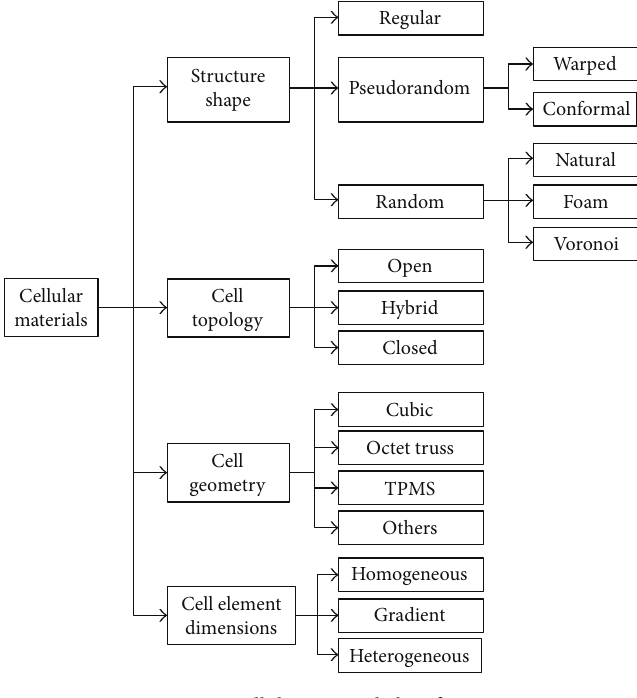
Figure 1: Cellular material classi fi